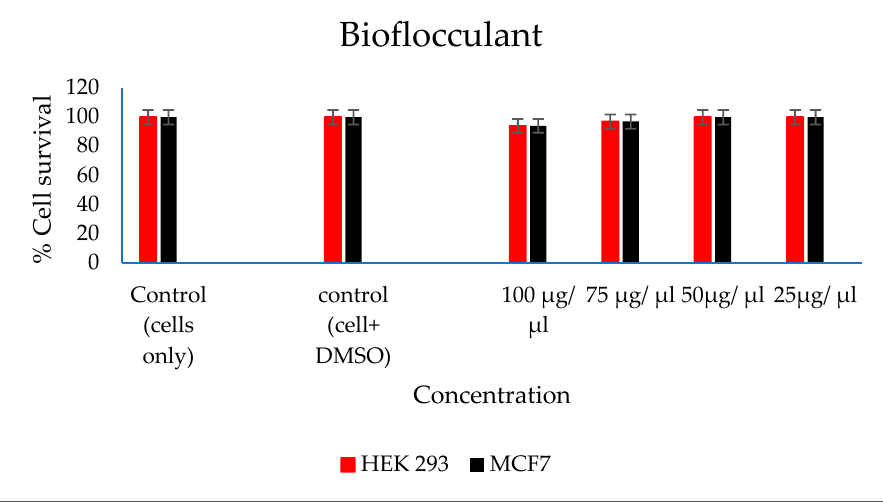
Figure 8. In vitro cytotoxicity effect of bioflocculant nanoparticles on HEK293 and MCF7